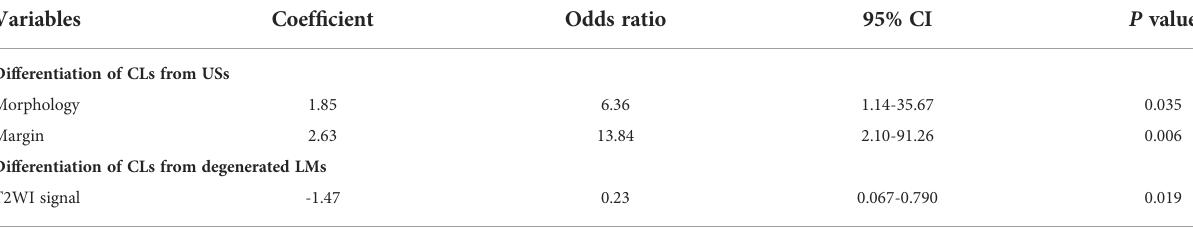
TABLE 2 Logistic regression analysis of clinical demographics and conventional MRI for differentiating CLs from USs and degenerated LMs. Variables Coef fi cient Odds ratio 95% CI P value